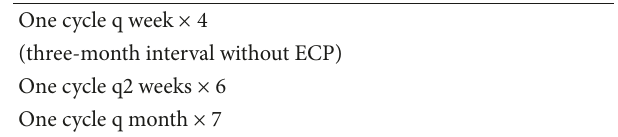
Table 1: Summary of ECP